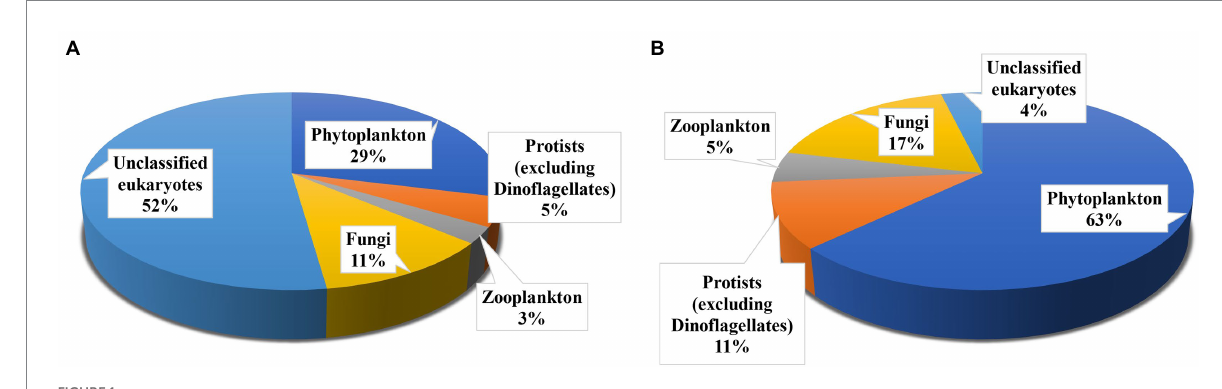
FIGURE 1 Operational taxonomic unit (OTU) richness of main groups in the ambient waters (A) , and Polyarthra gut contents samples (B)